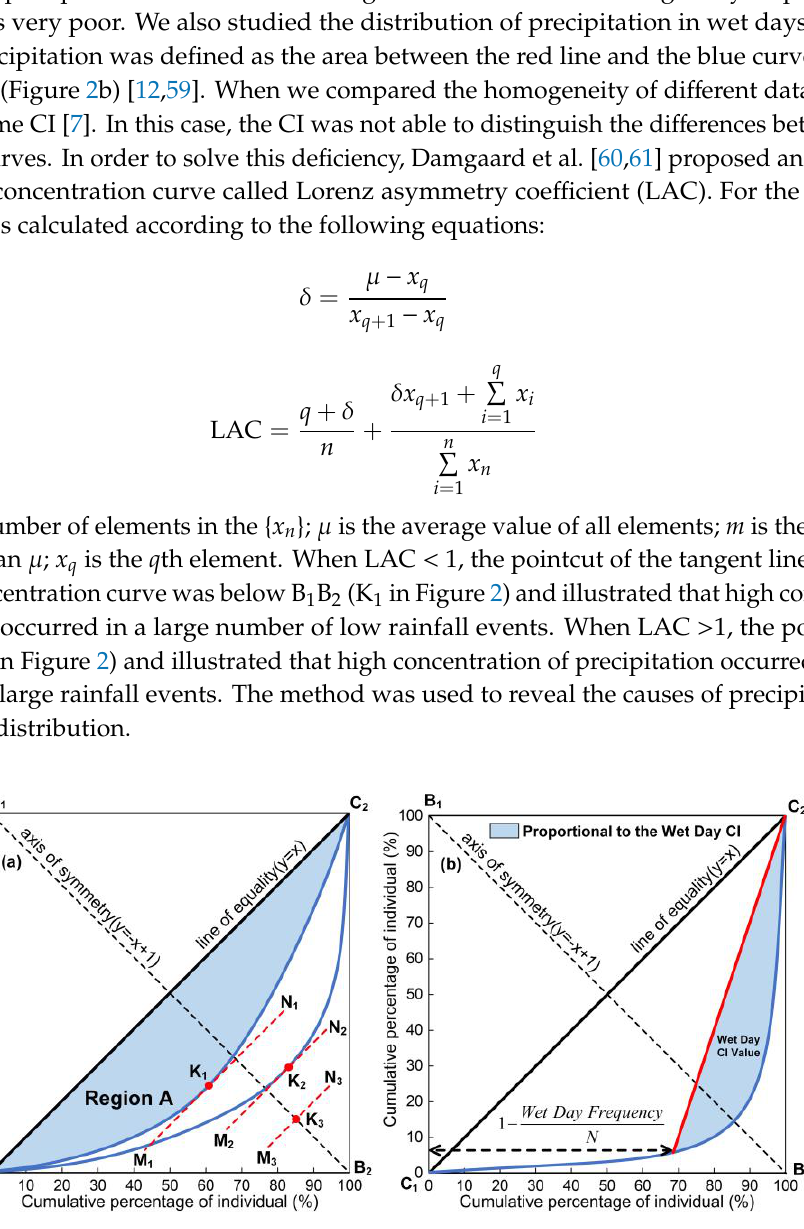
Figure 2. ( a ) Concentration curve of precipitation distribution. There are three types: One symmetric curve ( 1 3 2 C k C ) and two asymmetric curves ( 1 3 2 C k C and 1 3 2 C k C ); ( b ) concentration curve of precipitation in wet days (PRCP ≥ 1 mm) [6,59]. (5) The 1 3 2 C k C